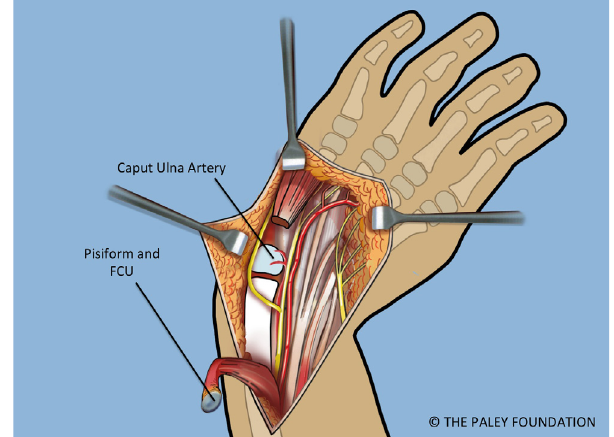
Figure 5. The FCU is reflected proximally. The circulation to the ulnar epiphysis comes from volar-radial. The ulnar and median nerves are decompressed into the hand.